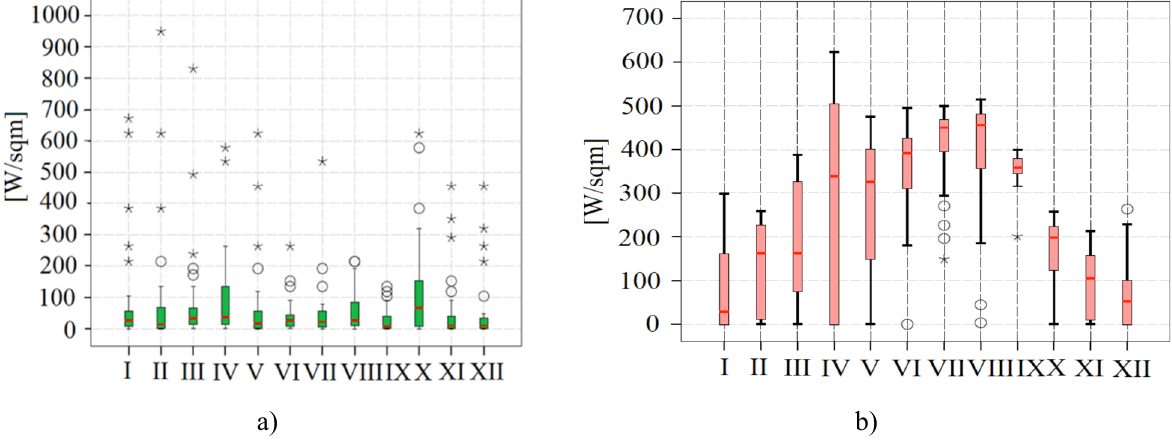
Fig. 2. Characteristics energy potential at Sfântu Gheorghe: (a) wind, (b)